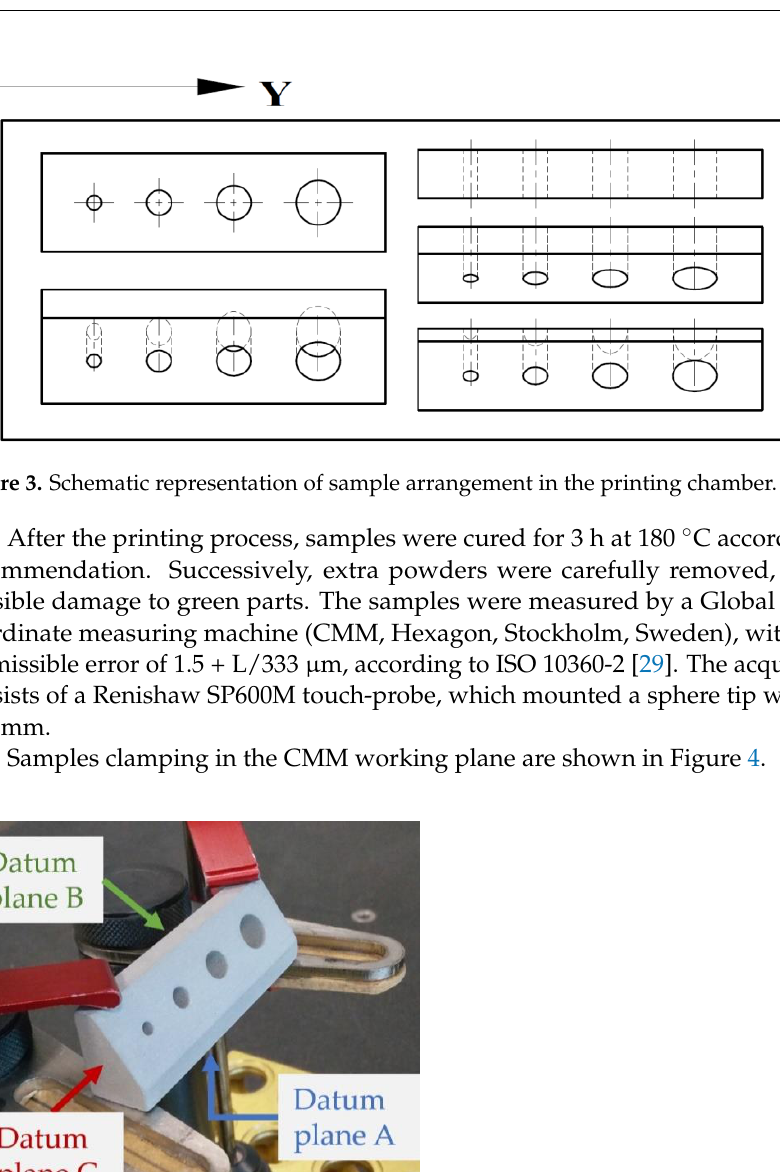
Figure 3. Schematic representation of sample arrangement in the printing chamber.